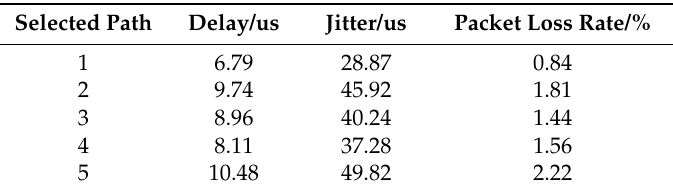
Table 1. Network link measurement